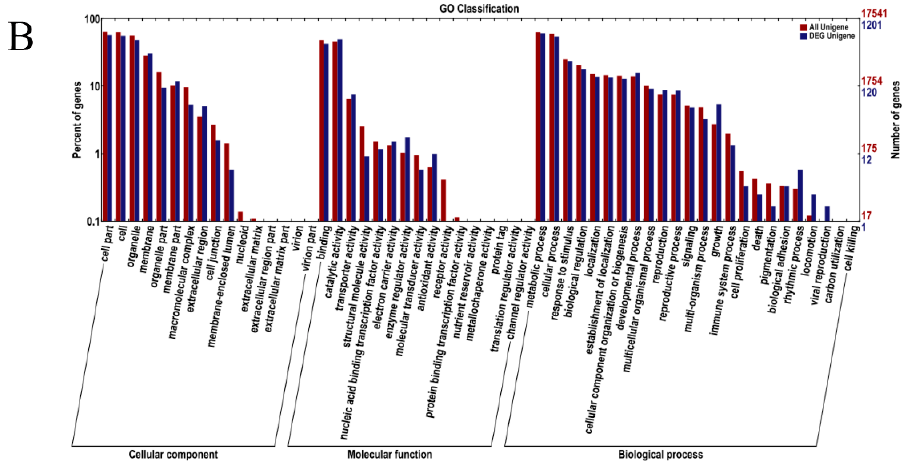
Figure 3. Gene Ontology Classification: ( A ) sequencing data from May 2013; and ( B ) sequencing data from May 2014. The unigenes are summarized into three main categories: cellular component, molecular function and biological process. The right side of the y -axis is the number of the genes; the left side of the y -axis is the percent of genes.